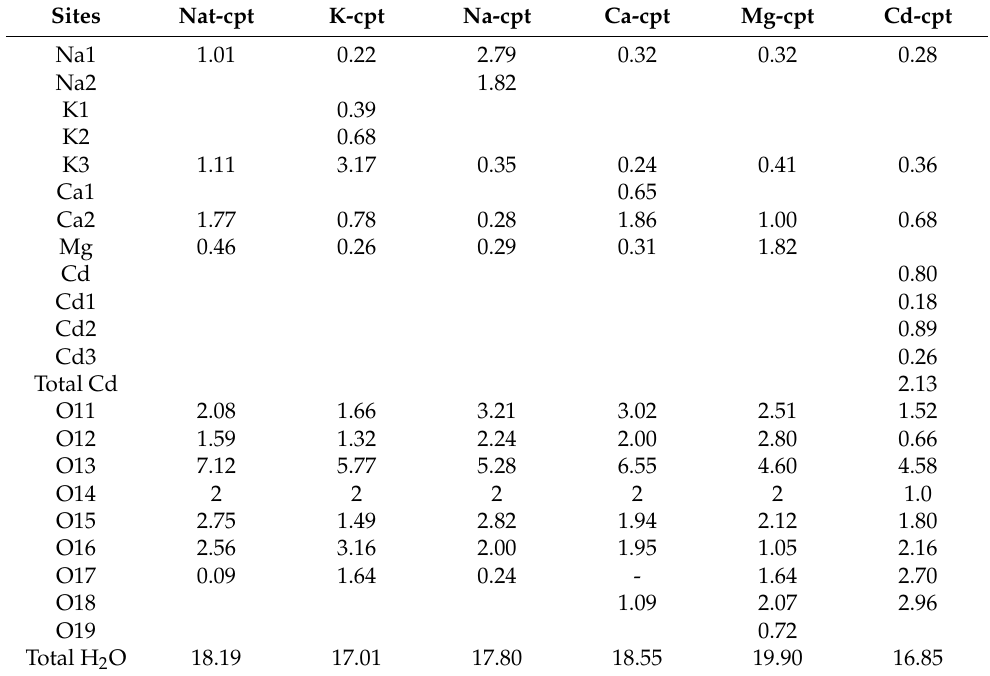
Table 5. Extra-framework sites, H 2 O molecules sites, and their occupancies per unit cell. Sites